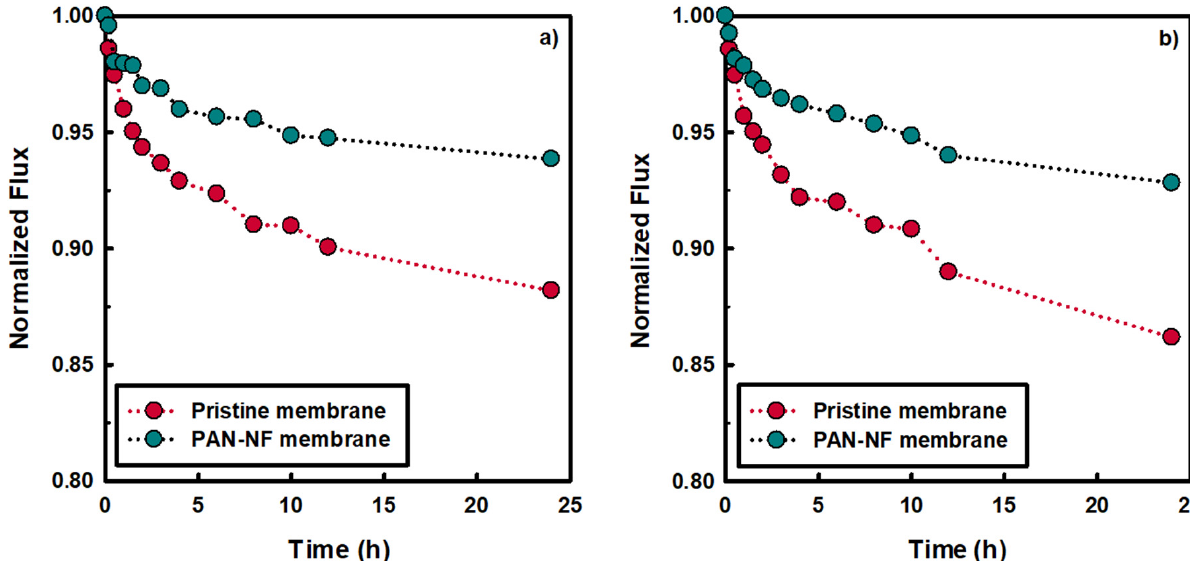
Figure 3. Normalized permeate flux as a function of time for modified and pristine PAN-NF membranes as a function of time. Operating conditions: ( a ) HA and ( b ) SA = 5 mg/L; pressure = 5 bar; stirring speed = 300 rpm; cross-flow velocity = 1 L/min; conductivity = 300 μ s/cm; temperature = 25 °C. The permeate and concentrate were recirculated back to the feed tank during filtration.